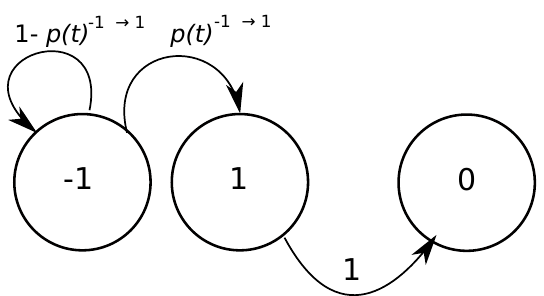
Figure 3. The state diagram of the automata adopted in PROPAGATOR . States − 1,1,0 stand for unburned cell, burning cell and burned cells, respectively. At a given time t , an unburned cell has a probability p − 1 → 1 to burn. Such probability is given by the overall state of the stochastic realization, initial, and boundary conditions. At the subsequent time step of the stochastic process, every burning cell is going to be set to a burned cell (and thus